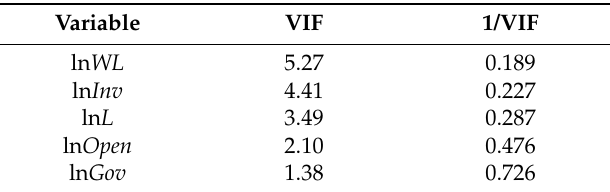
Table 5. Variance inflation factor